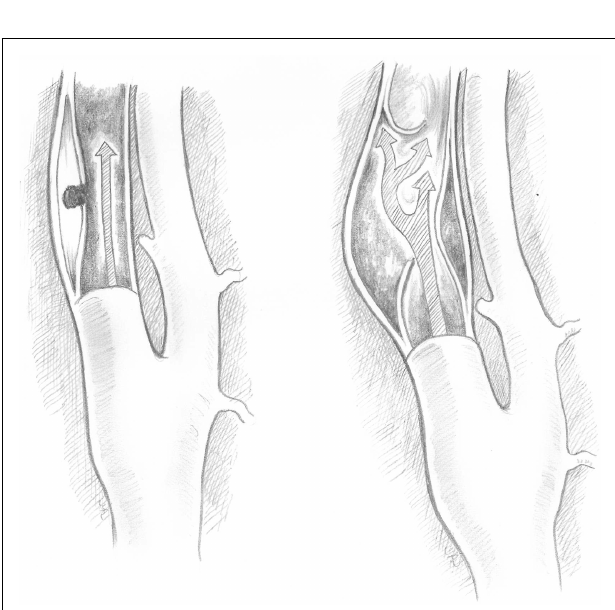
show varying degrees of luminal stenosis due to an